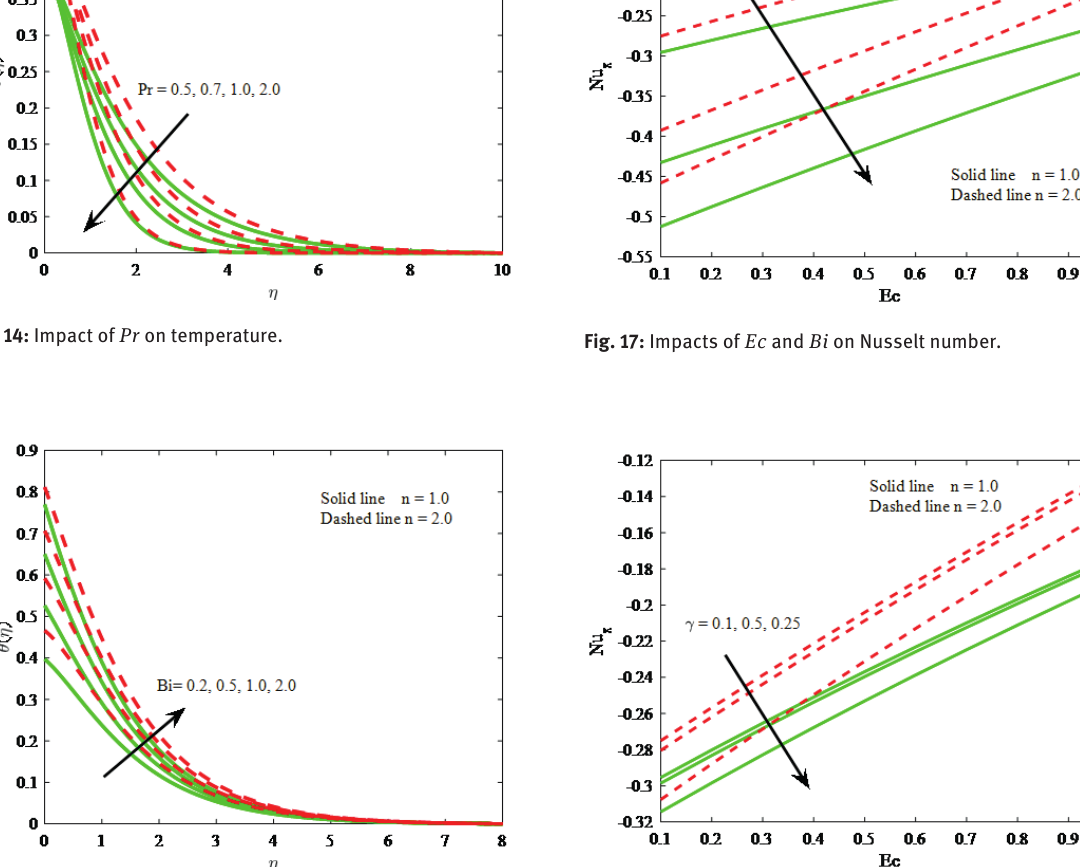
Fig. 18: Impacts of Ec and γ on Nusselt